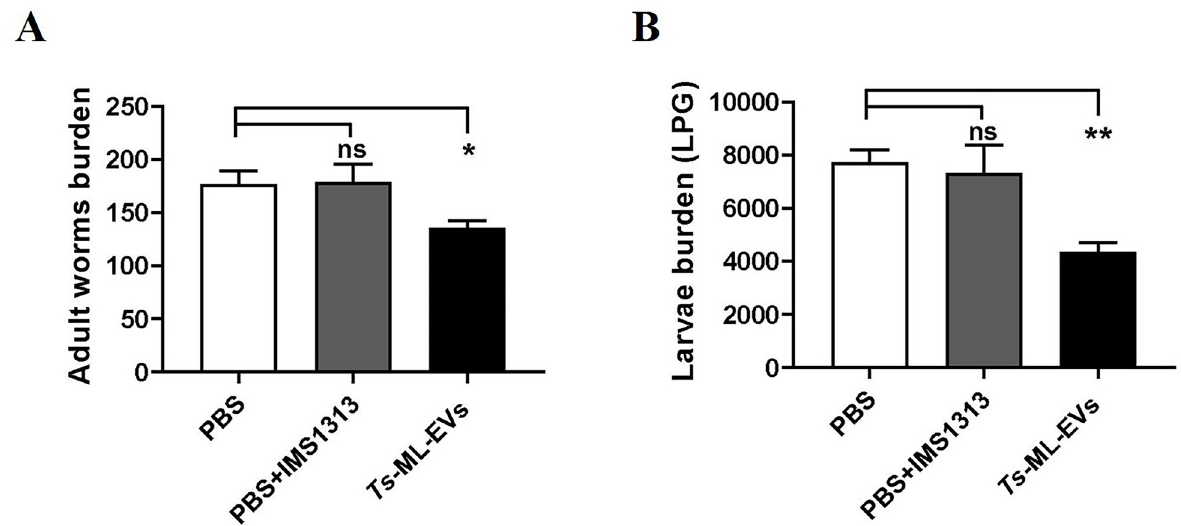
Fig 4. Immunization with Ts -ML-EVs elicited a delay in the course of the infection and increased the survival rate. (A) Worm burden from 4 vaccinated mice with mean and SD bar shown. � P < 0.05, �� P < 0.01, ��� P < 0.001. (B) The LPG from 4 vaccinated mice with mean and SD bar shown. Data were evaluated by Dunnett’s multiple comparison poet hoc test. All data are pooled from three independent experiments. � P < 0.05, �� P < 0.01, ��� P <